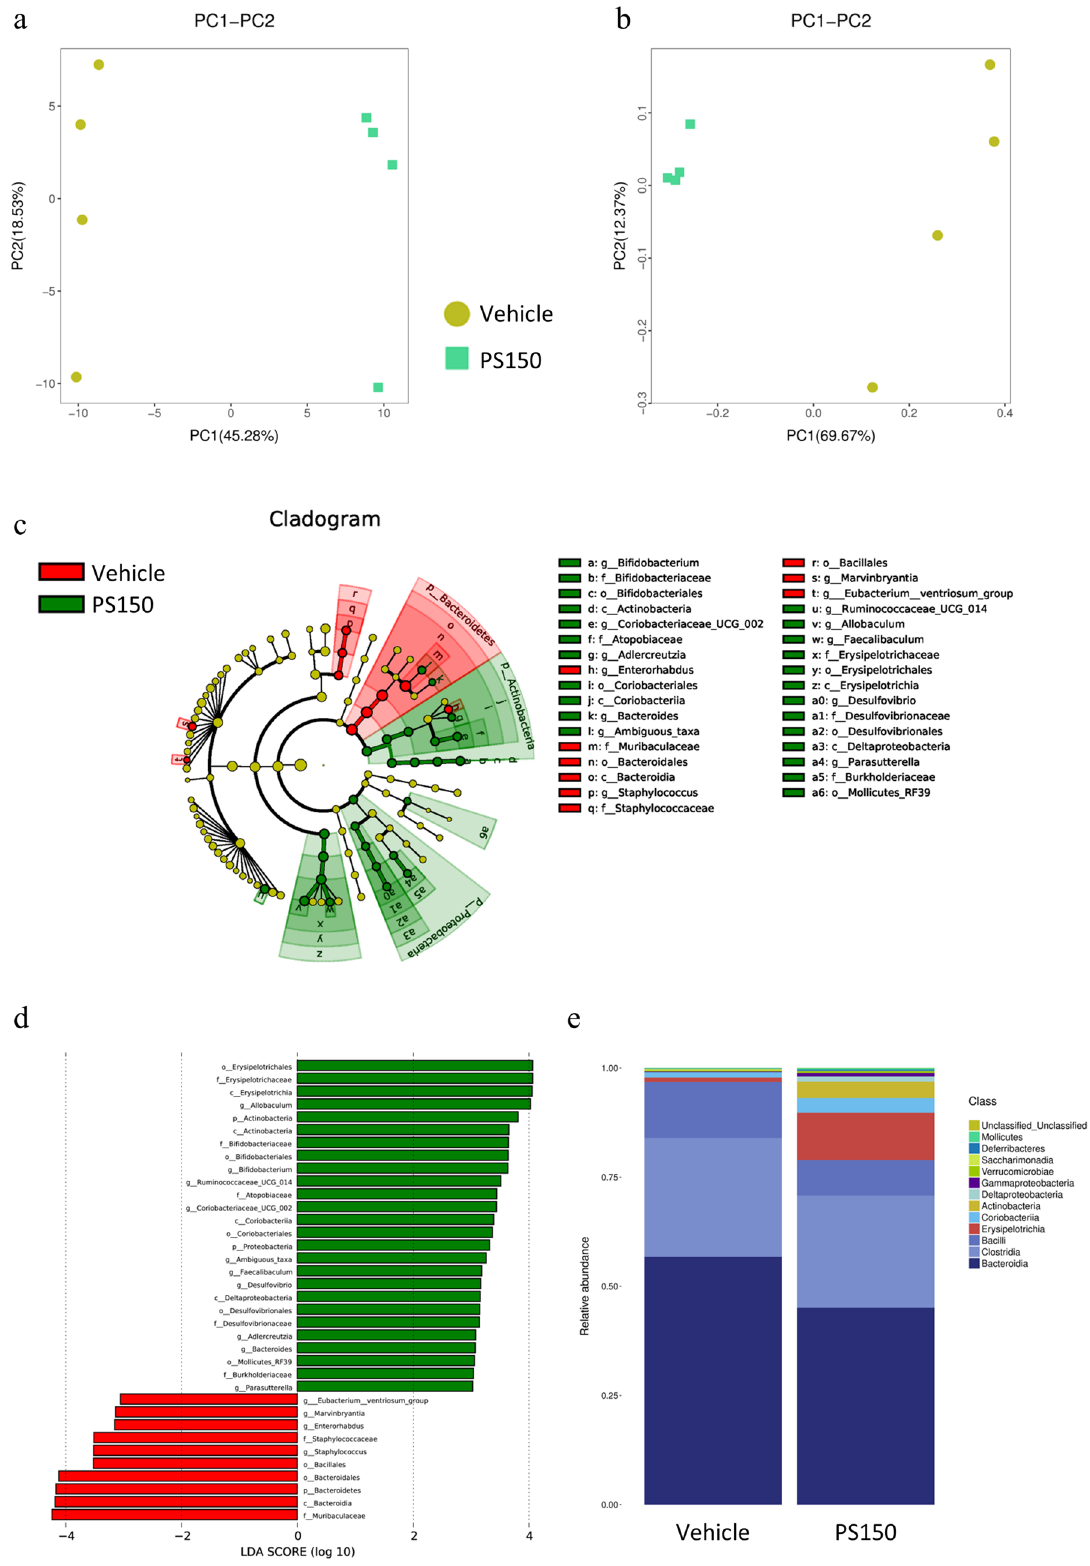
Figure 5. Differential microbiota composition of the fecal specimen from the cage change group. (a) PCA and (b) PCoA plot of fecal microbiota. (c) Cladogram from linear discriminant analysis effect size (LEfSE) and enriched taxonomy in either the control or PS150 group are colored red and green, respectively. (d) LDA score from LEfSE analysis. (e) The stacked plot of relative microbial distribution at the order